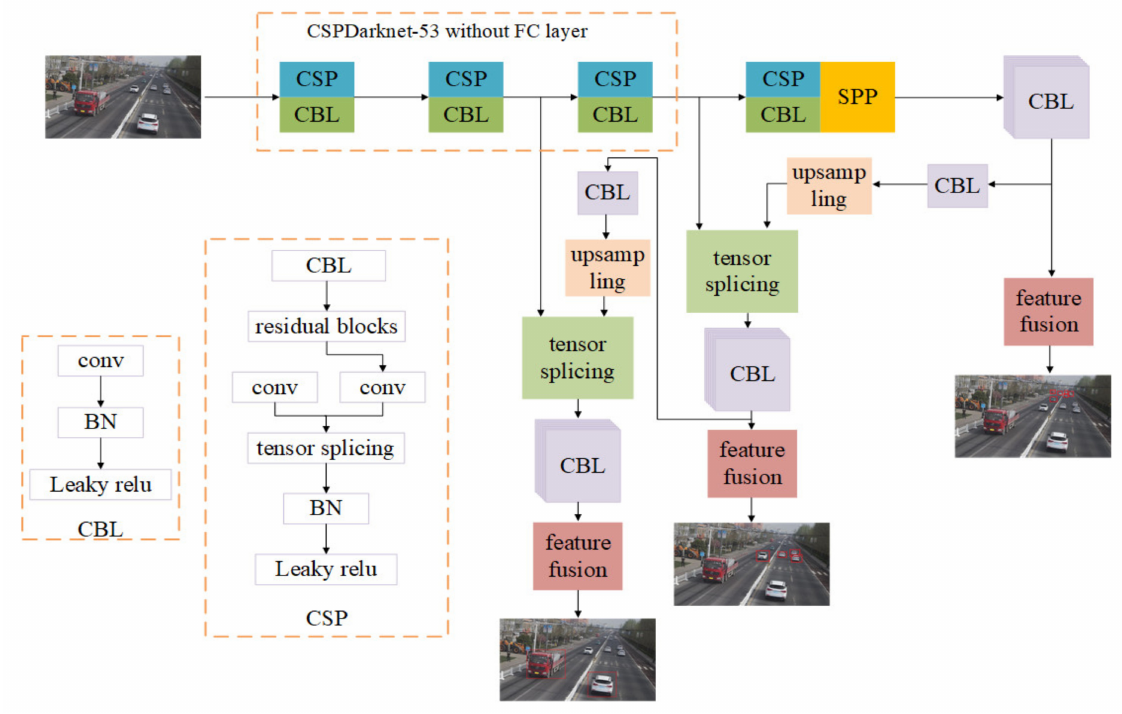
Figure 3. Improved YOLOv3 network structure